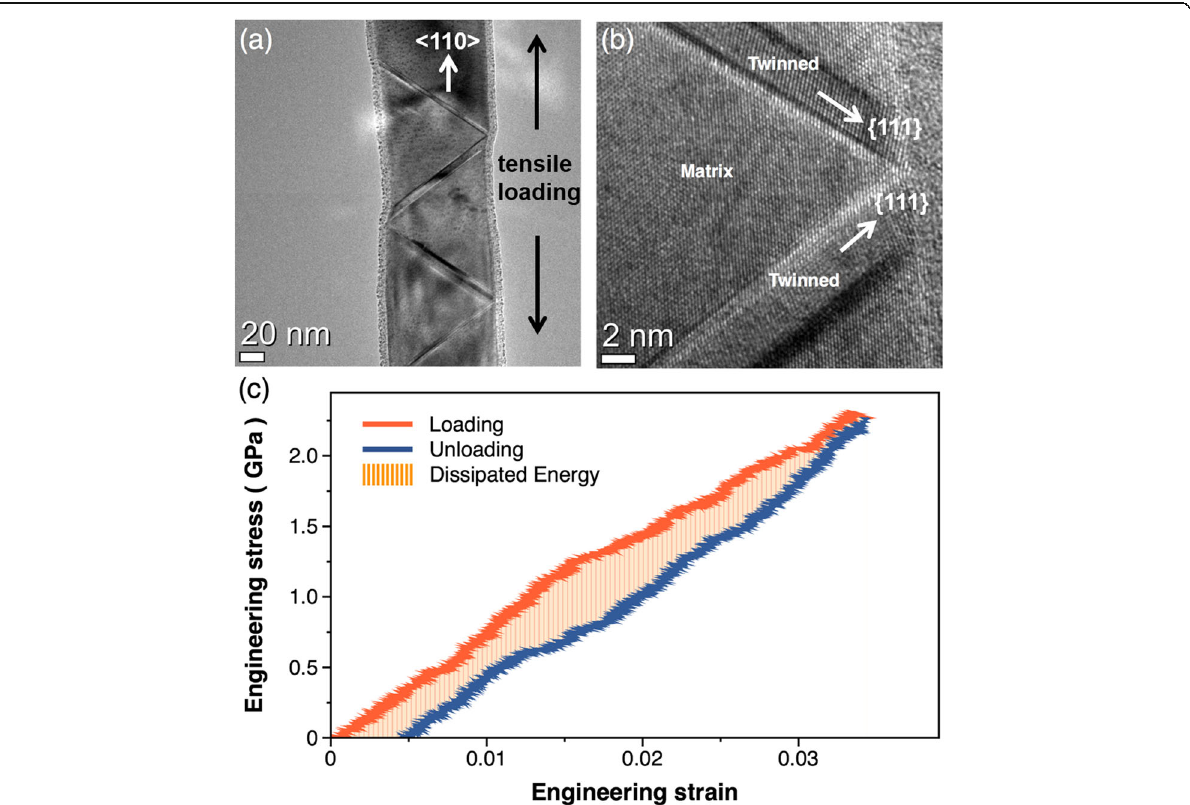
Fig. 5 a Representative TEM image of the tensile-test <110> Al NW, showing the formation of four twins with a zig-zag configuration. b Magnified view of the twinned region showing the interlocking configuration of the twins. c Stress-strain curve of the Al NW recorded by unloading the sample. Note that the Al NW was observed to yield with the formation of twins at σ = 2.3GPa (equivalently, at ε =